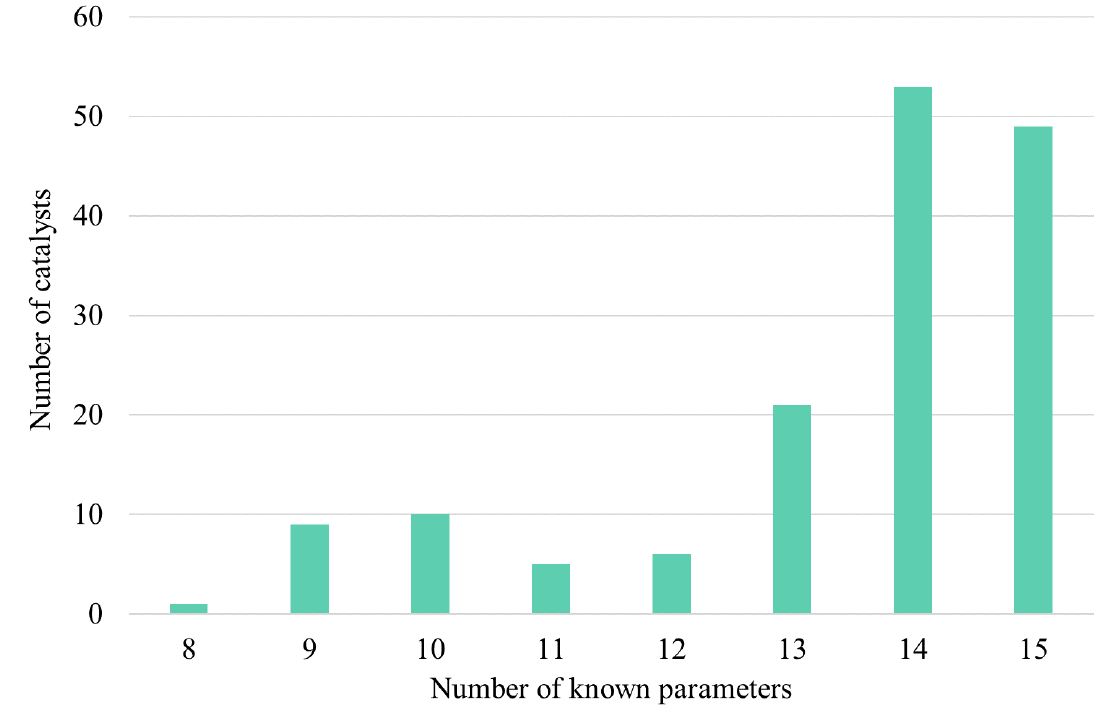
Figure 6. Information content of studied scientific